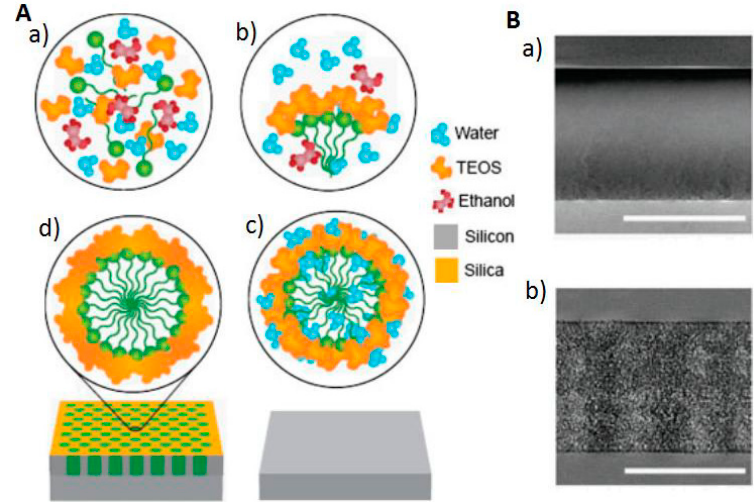
Figure 2. Production and assembly of mesoporous silica-based chips for proteomic uses. ( A ) Chemical changes taking place in the solution during the production phases of a mesoporous silica film; ( a ) fresh solution, ( b ) Micelles formation, ( c ) spin-coating process leading to self-assembly, ( d ) magnified image of a pore post-aging at high temperature. ( B ) SEM and TEM cross-sectional images of GX6 chip on a ( a ) bulk silicon wafer surface (upper) and ( b ) mesoporous silica film-coated silicon wafer surface (lower). Scale bar is 500 nm. Reproduced from Reference [34] with the permission of Wiley-VCH Verlag GmbH & Co. KGaA, Weinheim.